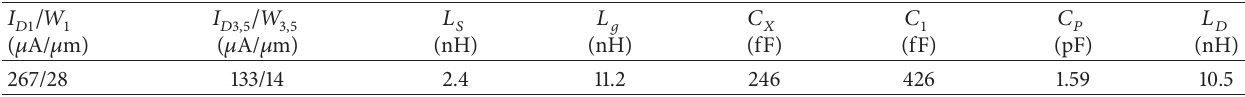
Table 2: LNA component